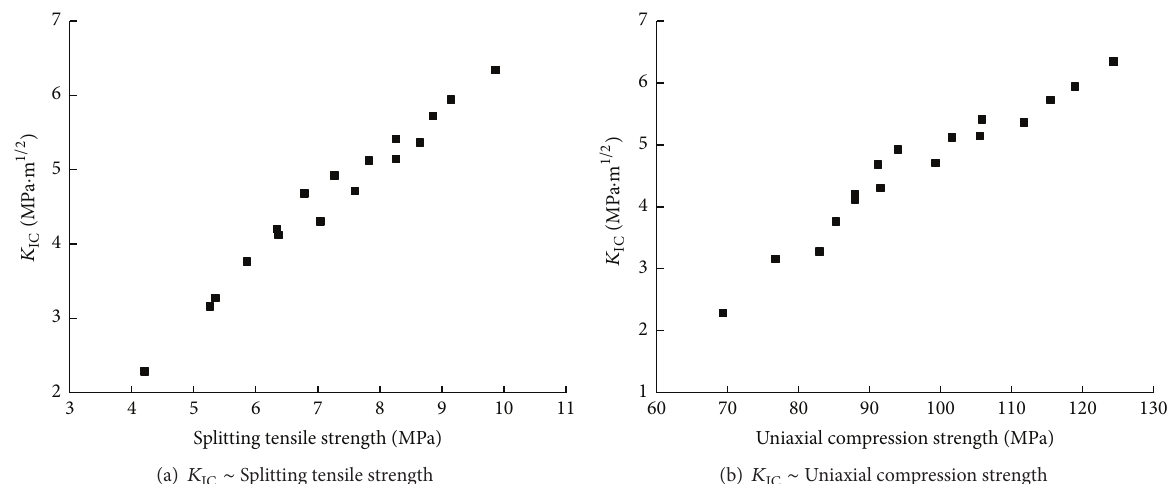
Figure 7: Relationship between splitting tensile strength, uniaxial compressive strength, and 𝐾 IC of granite specimens.